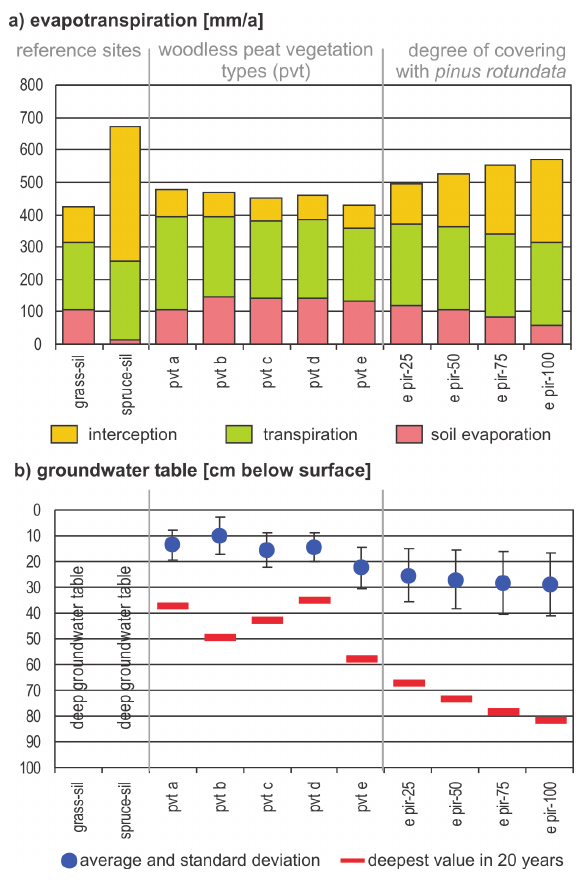
Fig. 4. Simulated long-term yearly average evapotranspiration and groundwater table for test sites with different peatland veg- etation type according to Russian ecotopes (“mikrolandˇsafty”), (a) Micro- Carex -fen, (b) Sphagnum -low shrub-heath, (c) Sphag- num -low shrub- Eriophorum -lawn, (d) Sphagnum - Carex -low shrub- Eriophorum -lawn, (e) Bog-pine- Sphagnum low-shrub-heath) and density of canopy (wood covering) (25 light covered, 50 strong opened, 75 opened, 100 closed).